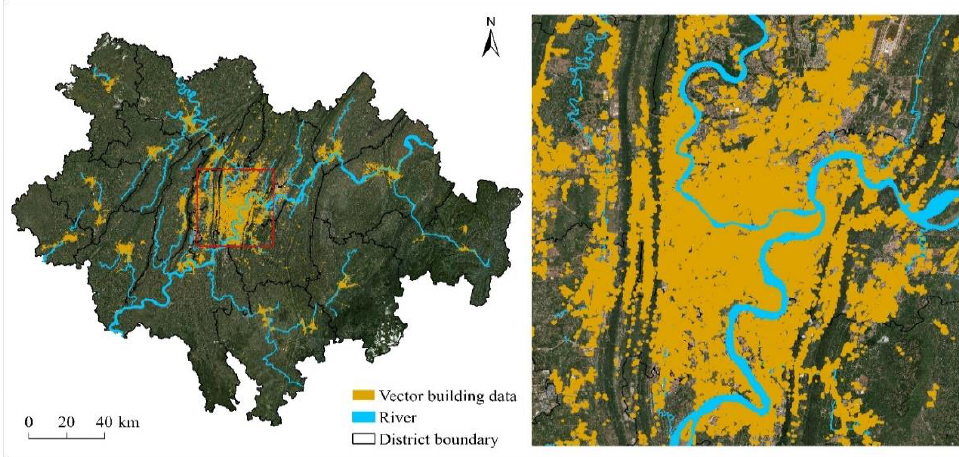
Figure 4. Physical urban area based on vector building